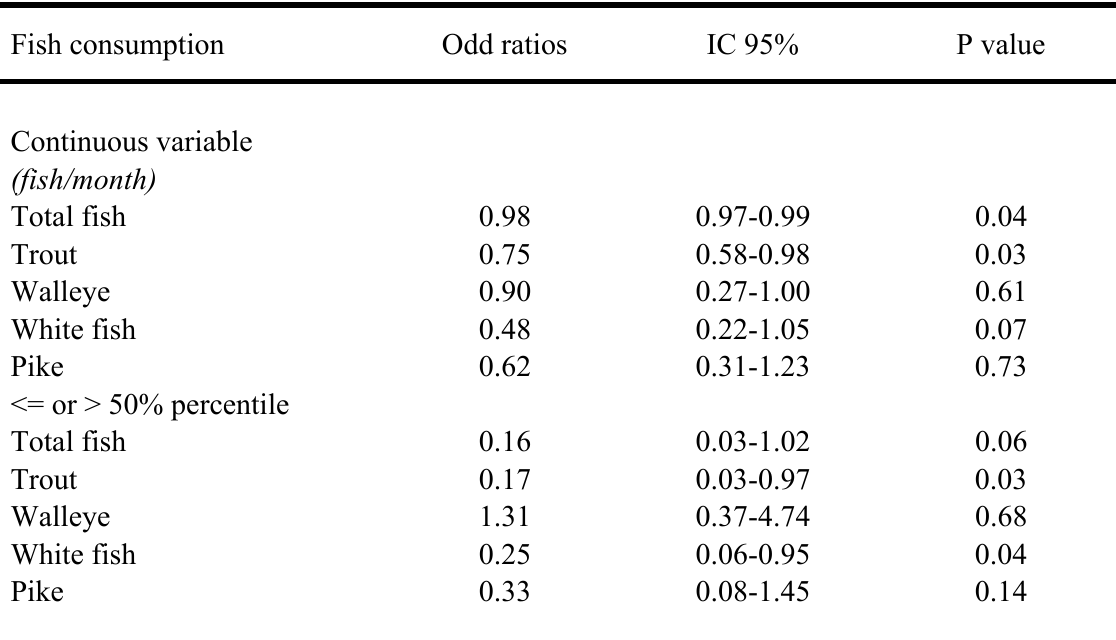
Table 3. Association between self-reported diabetes (Yes or No) and the frequency of fish intake